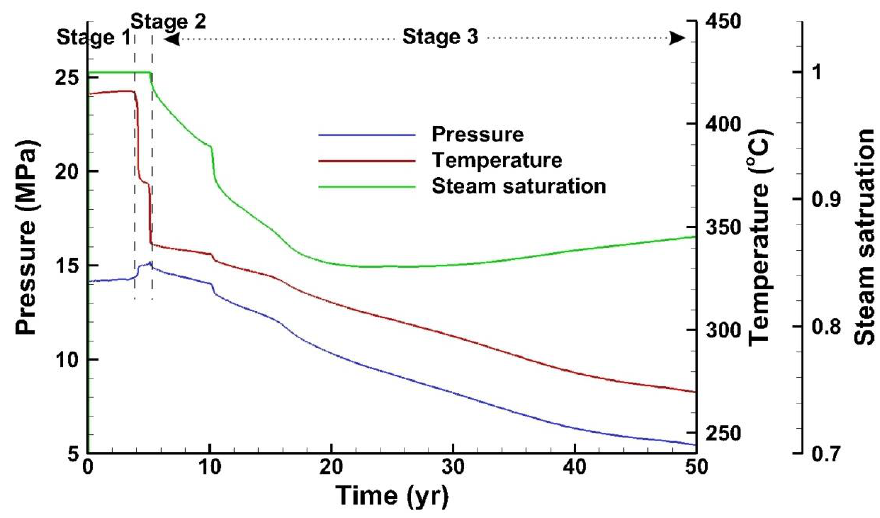
Figure 5. The evolution of pressure, temperature, and steam saturation at the production wellhead.